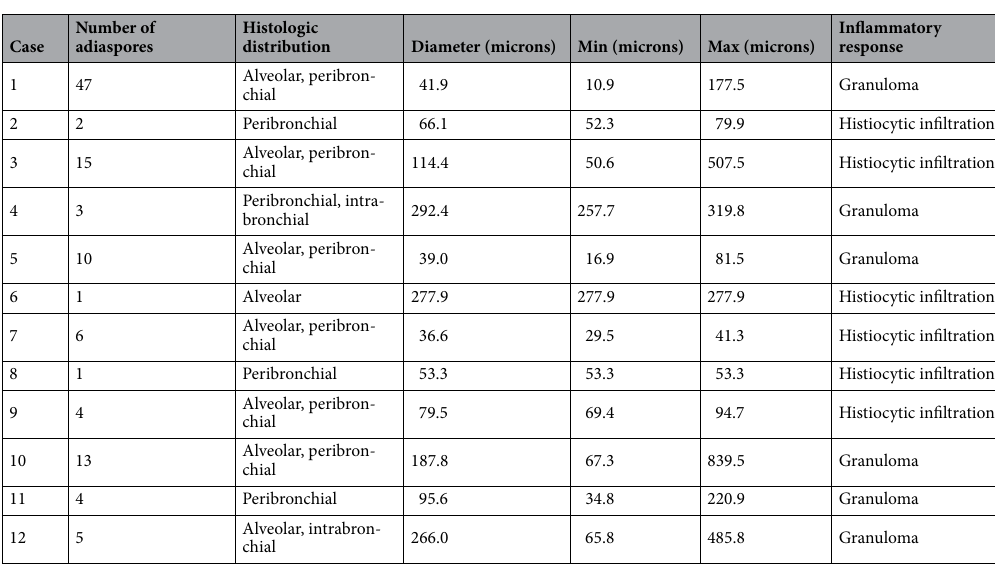
Table 2. Morphological characteristics of the adiaspores observed in lungs of wild armadillos died by motor vehicle collisions in Brazil,